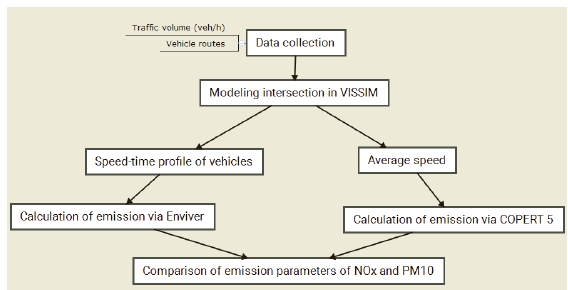
Fig. 6. Diagram of the procedure for selected modelled roundabout scenarios